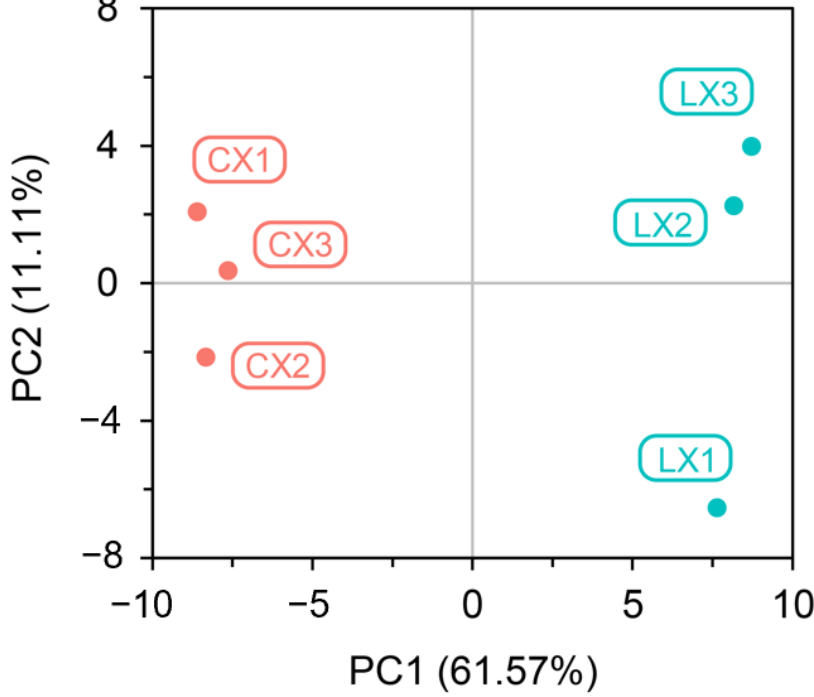
Figure 3. Principal component analysis (PCA) of the metabolites from CX and LX.